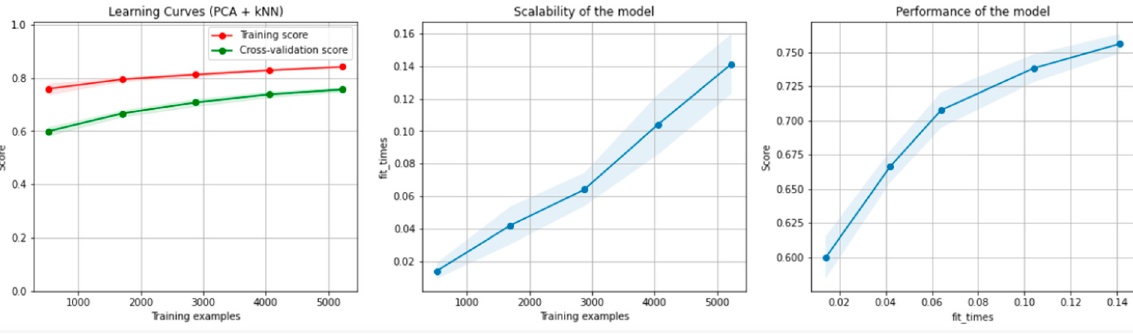
Table 8. Top 10 features selected by the SVM and kNN algorithms for the overlapping dataset. SVM kNN